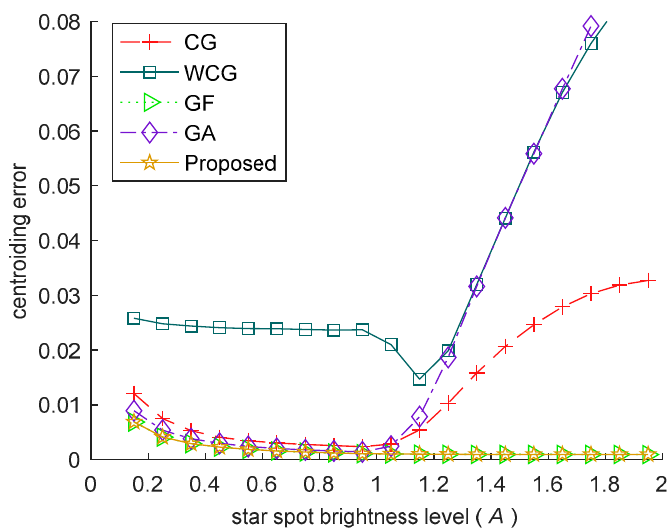
Figure 7. The centroiding error under different brightness level of the star spot. The accuracy of the proposed algorithm is almost stable under all the brightness levels.